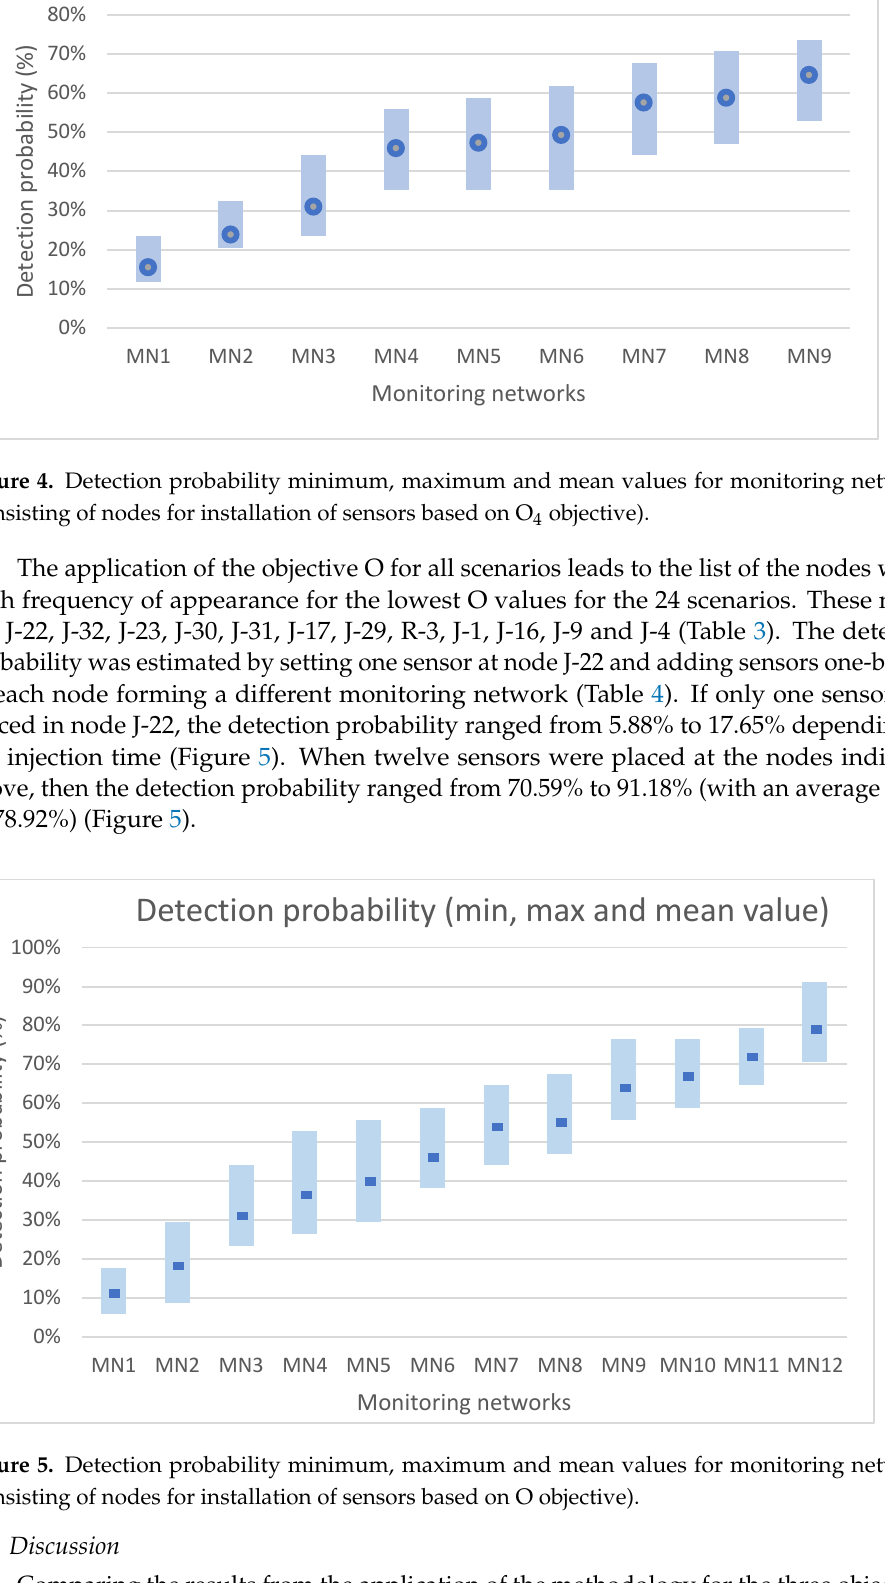
Figure 5. Detection probability minimum, maximum and mean values for monitoring networks (consisting of nodes for installation of sensors based on Ο objective).